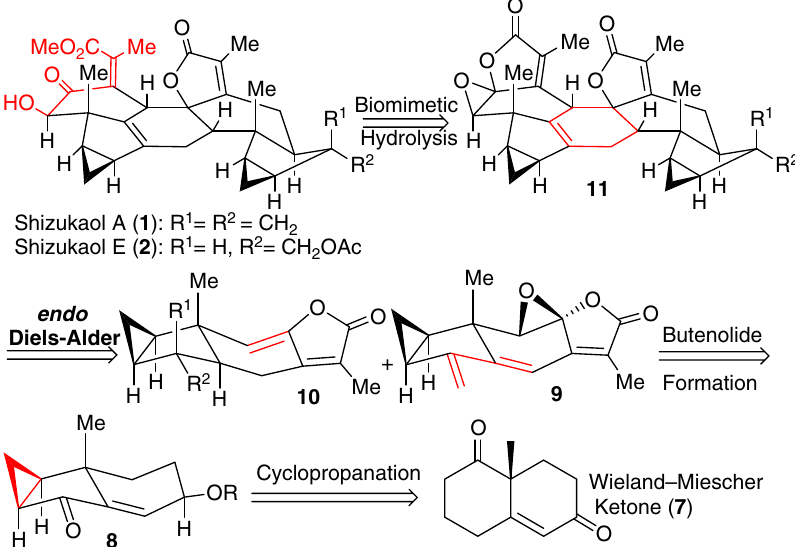
Fig. 3 Retrosynthetic analysis toward shizukaols A and E. This proposed protocol is featuring with a modi fi ed biomimetic approach involving an endo- Diels – Alder reaction and biomimetic